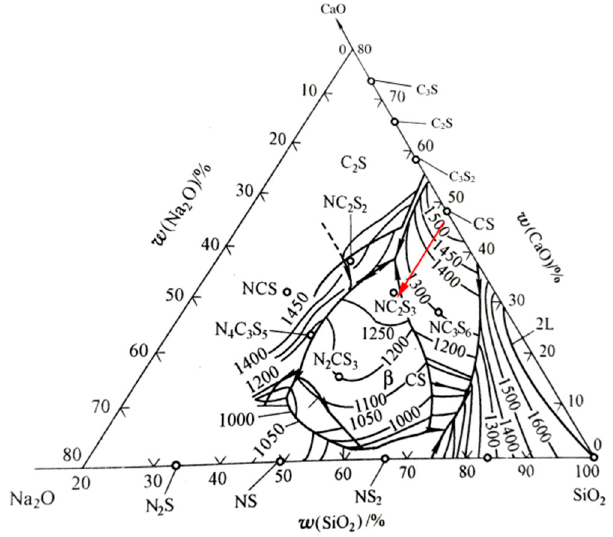
Figure 10. Phase diagram of the CaO-SiO 2 -Na 2 O slag system.